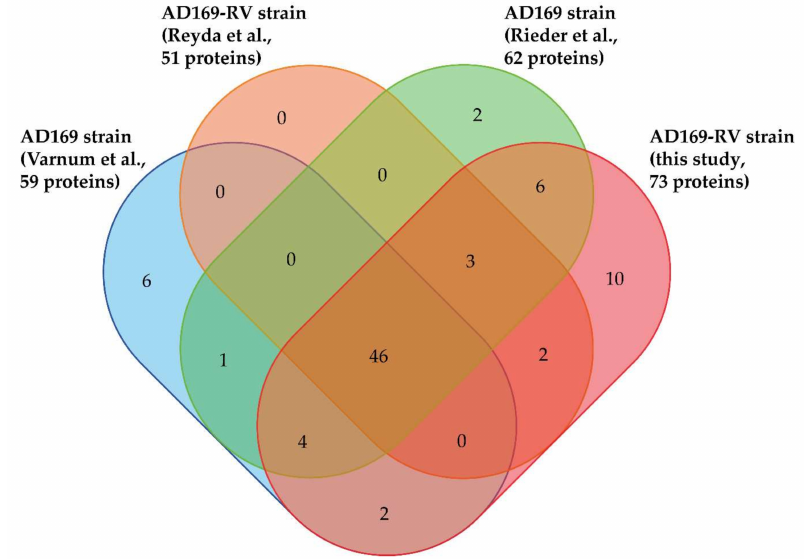
Figure 2. Venn diagram displaying overlap of viral proteins identified in HCMV virions in the